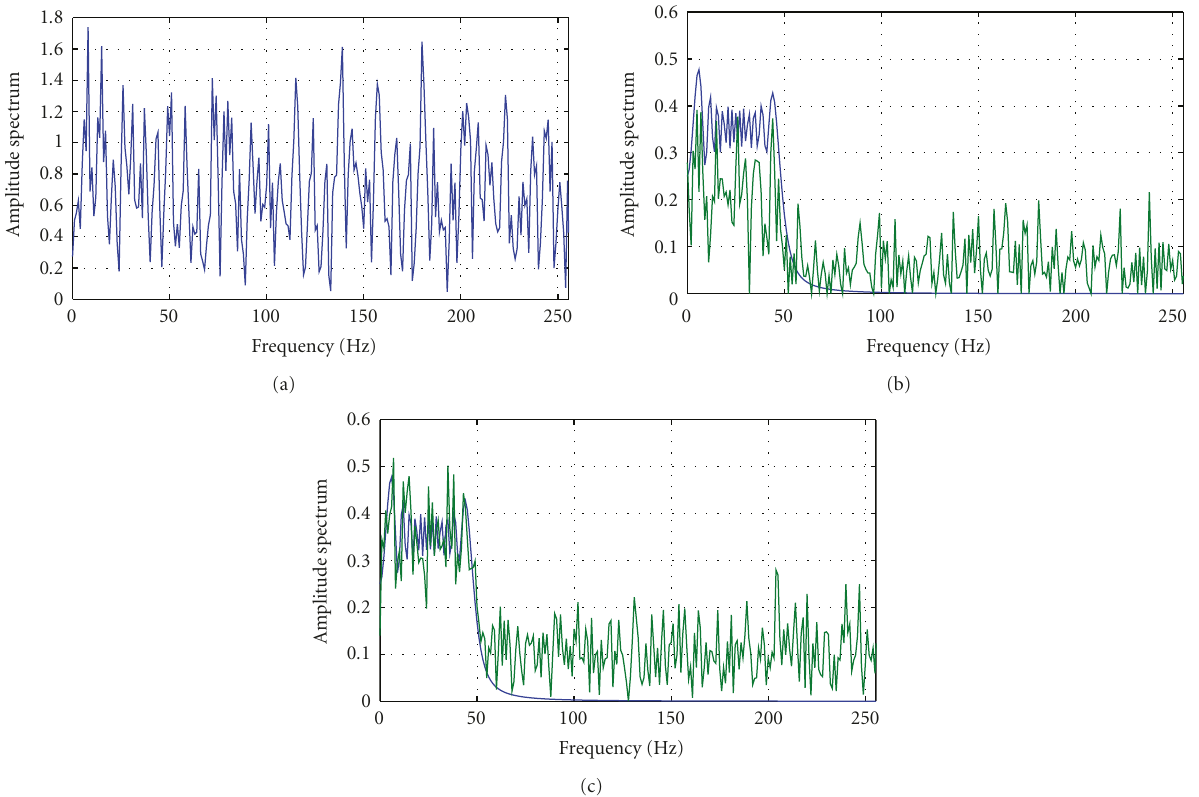
Figure 13: Amplitude spectrum estimates for FM signal s 2 ( n ) corrupted by noise with Cauchy PDF ( γ = 1) obtained by the standard DFT (a), MED-method of RDFT (b) and RDFT method based on CENS (c).